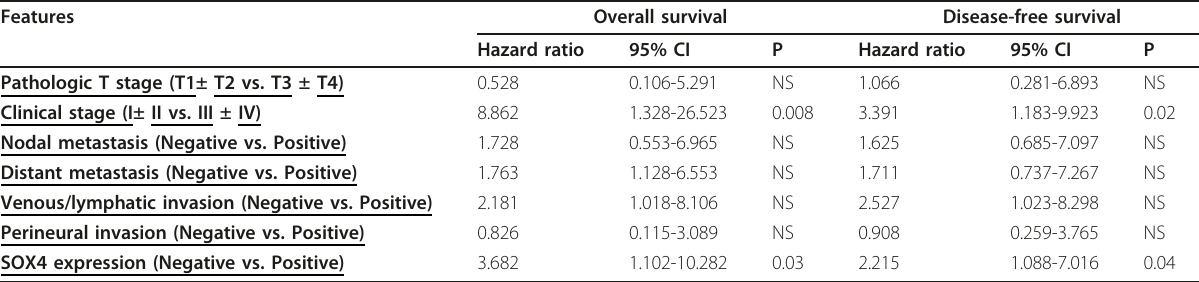
Table 3 Multivariate analysis of the association between prognosis and various clinicopathologic parameters in patients with